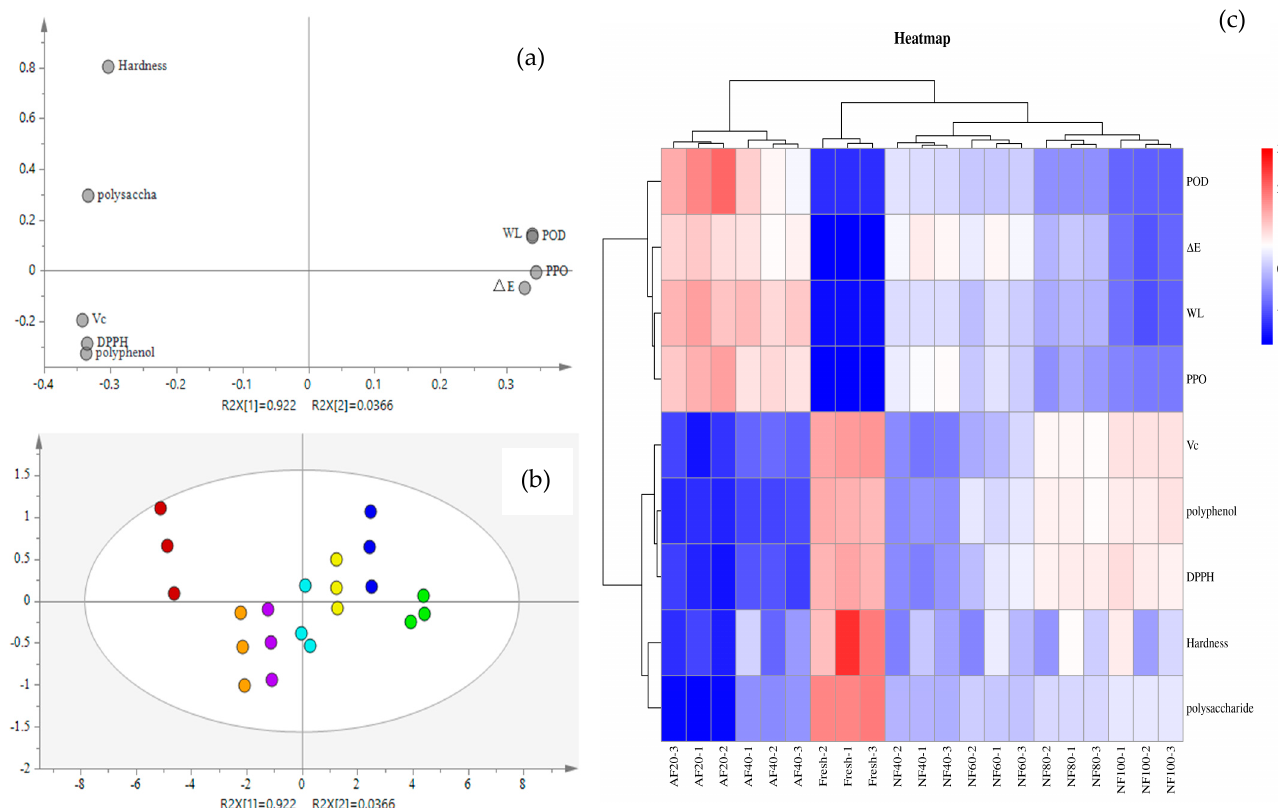
Figure 7. Loading scatter plot ( a ) and Score plot ( b ) of principal component analysis, and heatmap combined with the dendrogram of cluster analysis ( c ) were obtained based on the determined quality attributes.